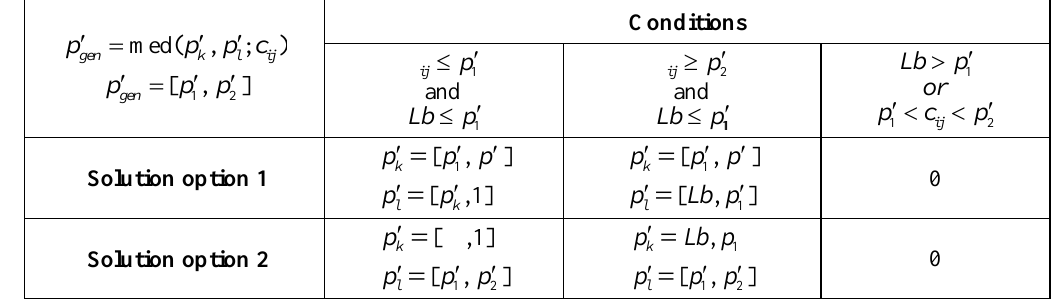
p  and p  in parametrized operations k l